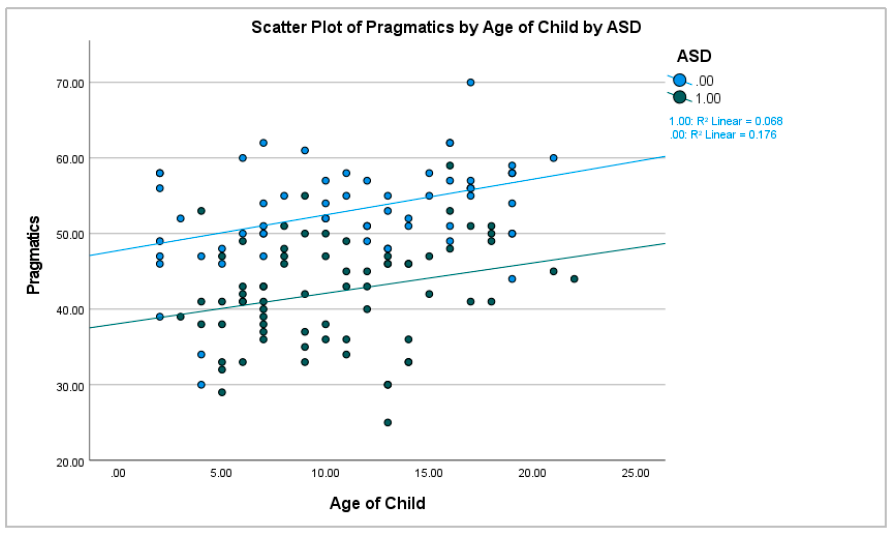
Figure 2. Scatterplot of the age by group effect on pragmatics.